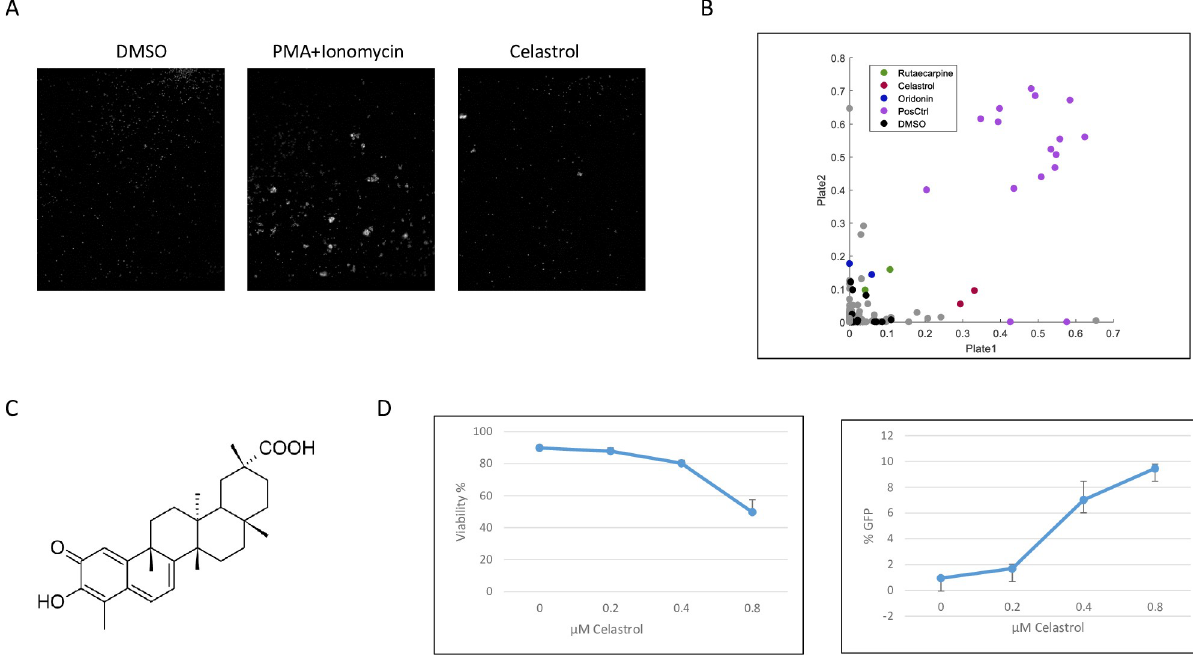
Fig 1. Image-based screen of natural compound library. A. Images of resting CD4 + T cells treated with PMA + ionomycin (positive control), DMSO (negative control), and celastrol (10 μ M). B. Scatter plot showing the aggregation index of each compound duplicates in the 2 replicate plates. Positive control replicates are in purple, DMSO negative control replicates in black, inactive compounds in grey and potential hits, namely rutsecarpine, celastrol and oridonin in green, red and blue, respectively. C. Structure of celastrol. D. Jurkat 2D10 cells were treated with the indicated concentrations of celastrol for 24 hours. Reactivation of HIV-1 was quantified by flow cytometry analysis of eGFP expression (left panel); cell viability was quantified by flow cytometry using Vi-Cell (Beckman Coulter). The data presented in Fig 1D are representative of more than three biological replicate experiments.